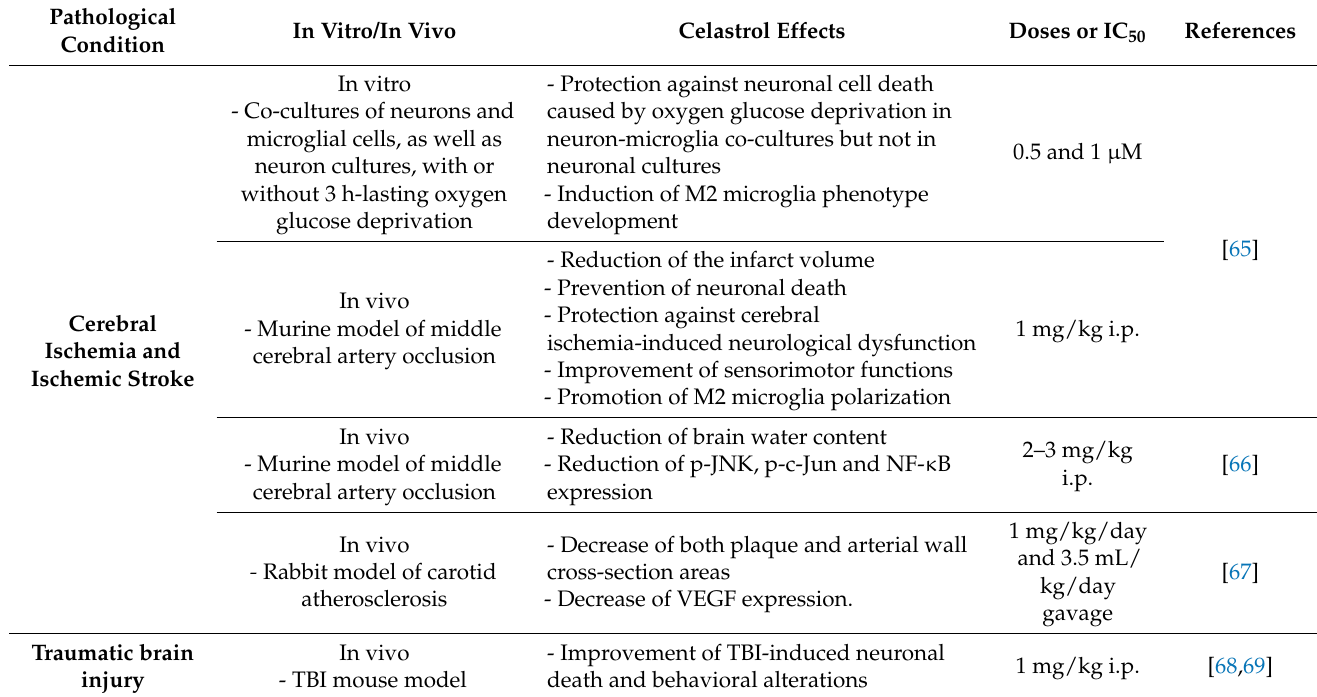
Table 2. Effects of celastrol in Cerebral Ischemia, Ischemic Stroke, and Traumatic Brain Injury. Pathological